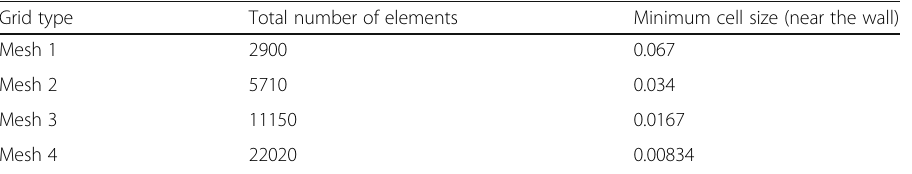
Grid type Total number of